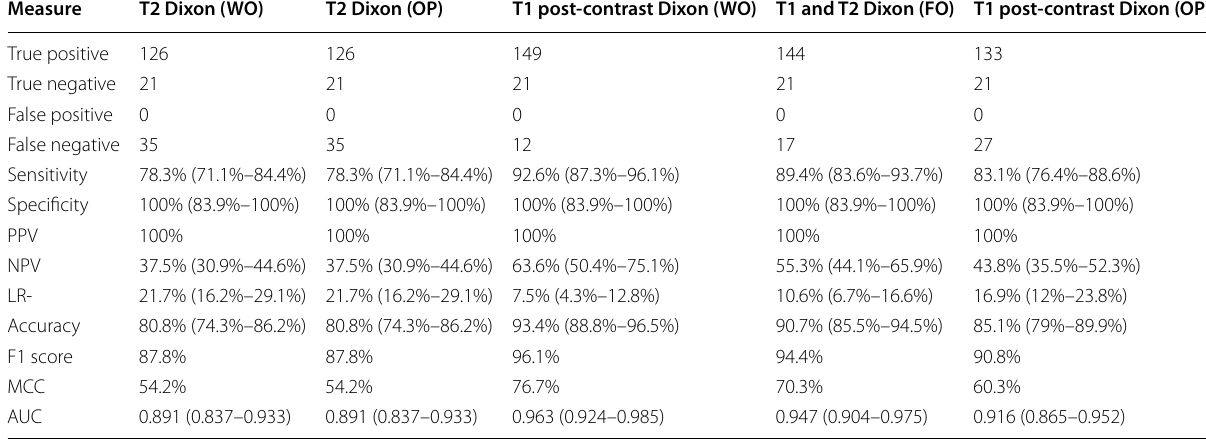
95% confidence intervals are presented between brackets All measures were calculated by Confusion Matrix Online Calculator (https:// onlin econf usion matrix. com, accessed December 2, 2021) [18] and MedCalc Software Ltd. Diagnostic test evaluation calculator, Version 20.018 (https:// www. medca lc. org/ calc/ diagn ostic_ test. php, accessed December 2, 2021) [19] PPV positive predictive value; NPV negative predictive value; LR- negative likelihood ratio; MCC Matthews correlation coefficient; AUC area under the curve